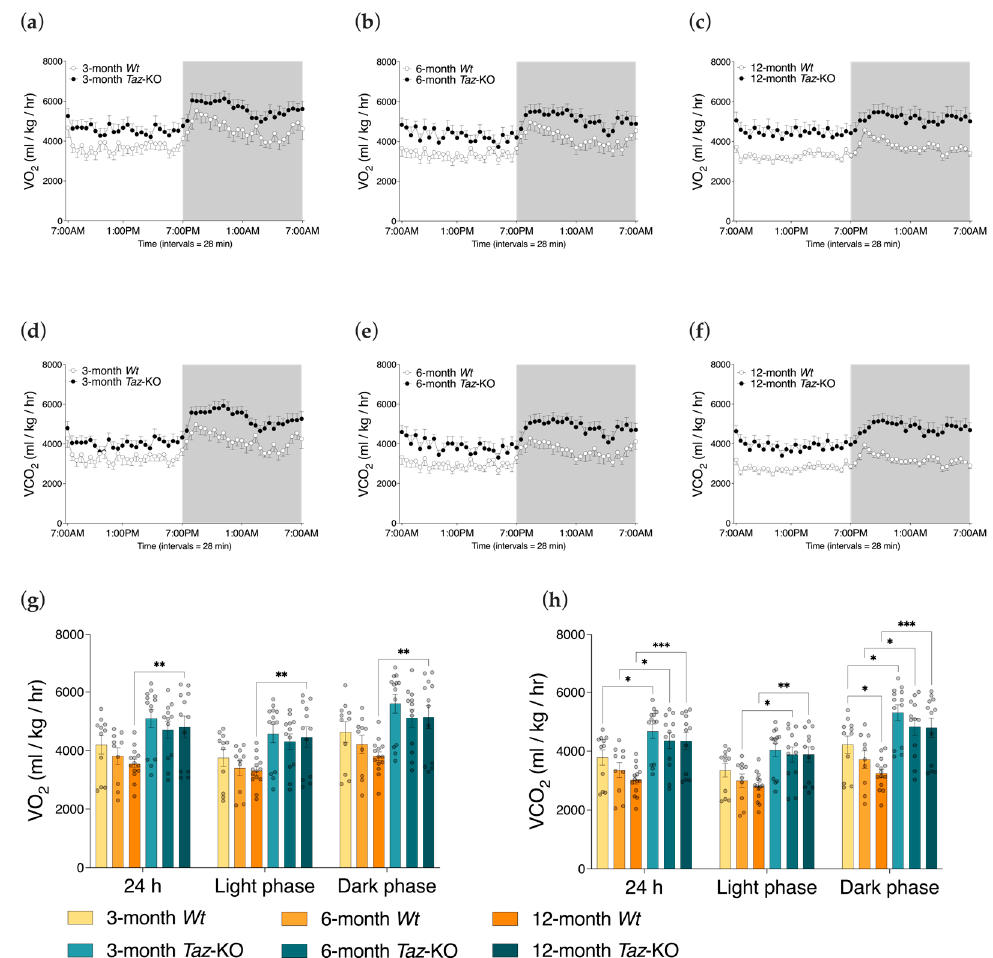
Figure 5. Oxygen consumption and carbon dioxide production by Taz -KO and Wt mice. Three separate mouse cohorts, aged 3, 6, and 12 months, were housed in metabolic chambers for 24 h. Representative plot of whole-body oxygen consumption rates (VO 2 ) ( a – c ) and carbon dioxide production rates (VCO 2 ) ( d – f ) normalized to total body weight. Dark (denoted by shaded background) and light (denoted by unshaded background) cycles are shown. The bar graphs of the daily averages, in addition to averages by photoperiod, of VO 2 ( g ) and VCO 2 ( h ) are shown. Statistical analysis was performed using two-way ANOVA followed by Bonferroni’s multiple comparisons tests. Data are means ± SEM ( n = 10–14). * p < 0.05, ** p < 0.01, *** p < 0.001.